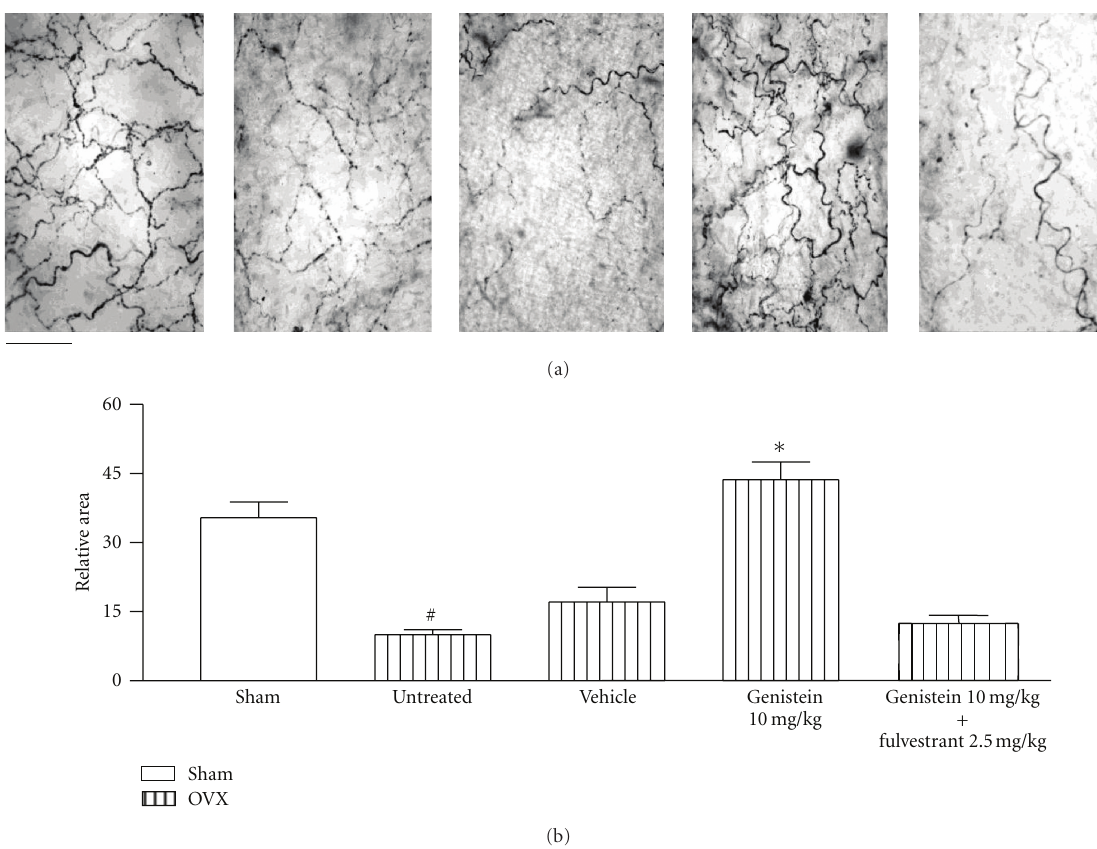
Figure 6: Immunohistochemistry for CGRP. (a) Representative microphotographs of CGRP-immunoreactive fibers surrounding mesenteric arteries in myenteric plexus preparations of sham-operated as well as of OVX female rats. Either genistein (10mg/kg p.o.) or genistein plus fulvestrant (10mg/kg p.o. and 2.5 mg/kg s.c., resp.) were administered daily during 3 days. The photomicrographs were captured at 400x magnification; the scale bar indicates 50 μ m. (b) Bars represent the mean ± SEM ( n = 4) of relative morphometric units measured as stained area/total area. Specific immunoreactivity in every tissue was calculated as the di ff erence between anti-CGRP-incubated and nonprimary antibody-incubated samples. # P < 0 . 001 between sham and untreated-ovariectomized female rats. ∗ P < 0 . 01 between genistein-treated and either genistein plus fulvestrant-treated or the corresponding vehicle-treated OVX